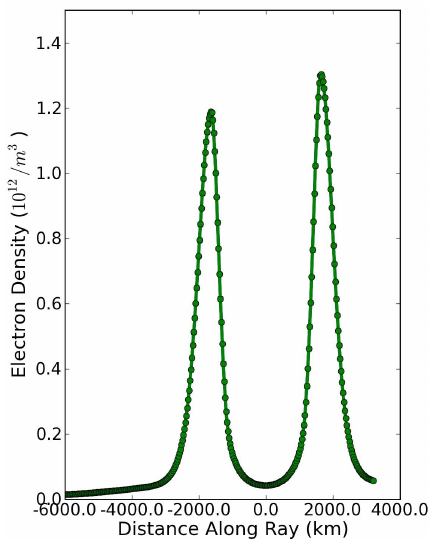
Fig. 9. Electron density along an occultation ray-path for the storm day, GAIM model case, assuming a spacecraft at COSMIC altitude of